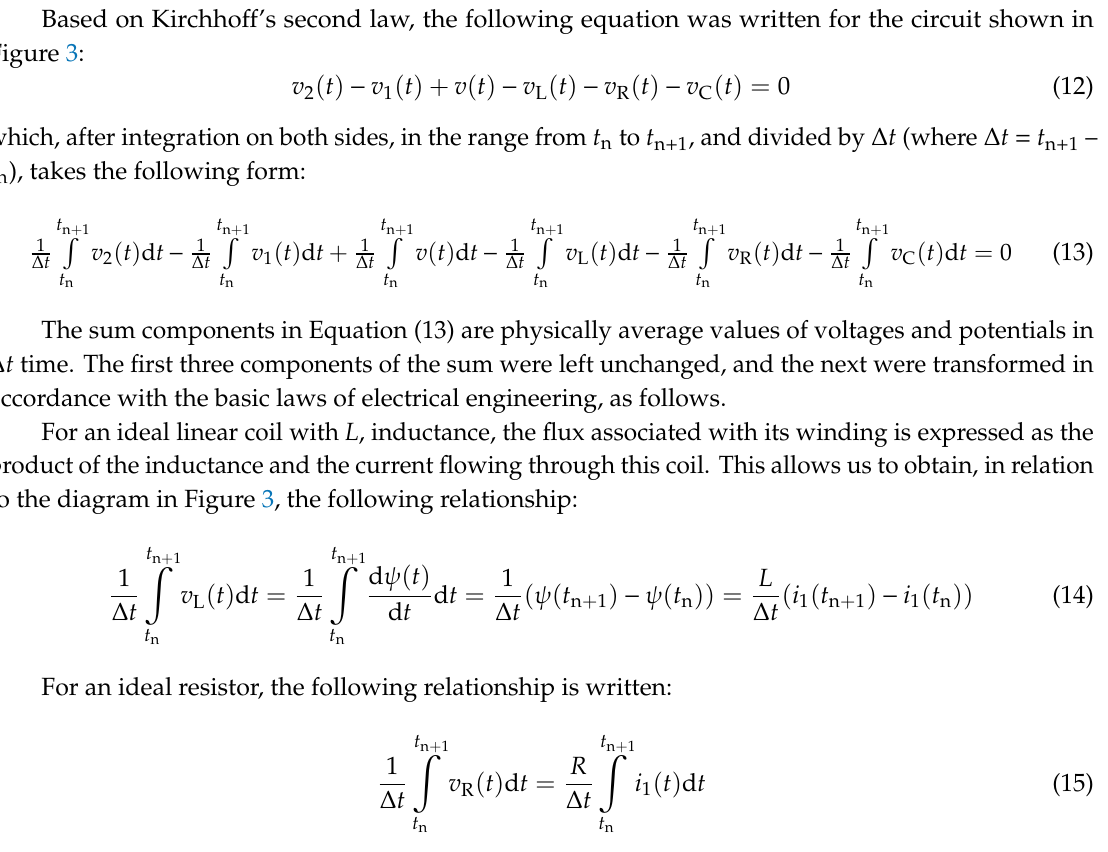
Figure 3. Schematic diagram of the example of an electric branch.